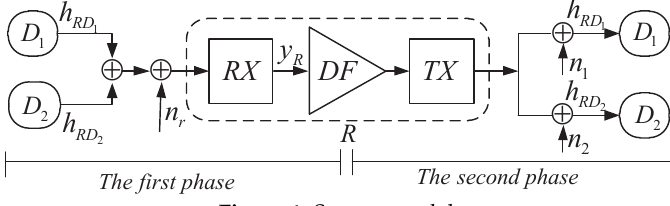
Figure 1. System model.